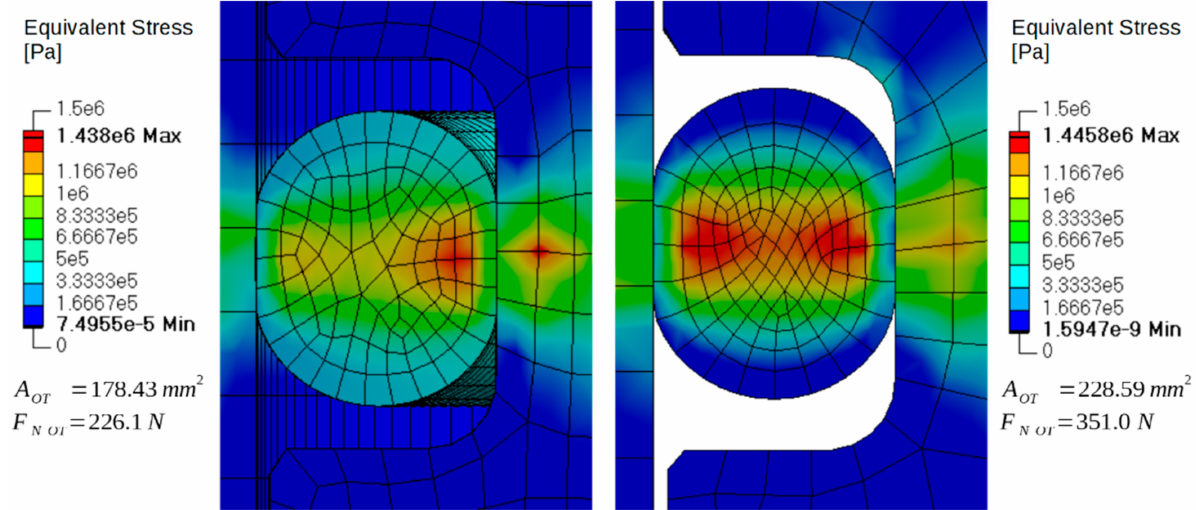
Figure 3. Comparison of the equivalent stress distribution in a rotational symmetric FEM setup ( left ) and a flat 2.5 D FEM setup ( right ) with the resulting contact area A OT and circumferential O-ring/tube contact normal force F NOT